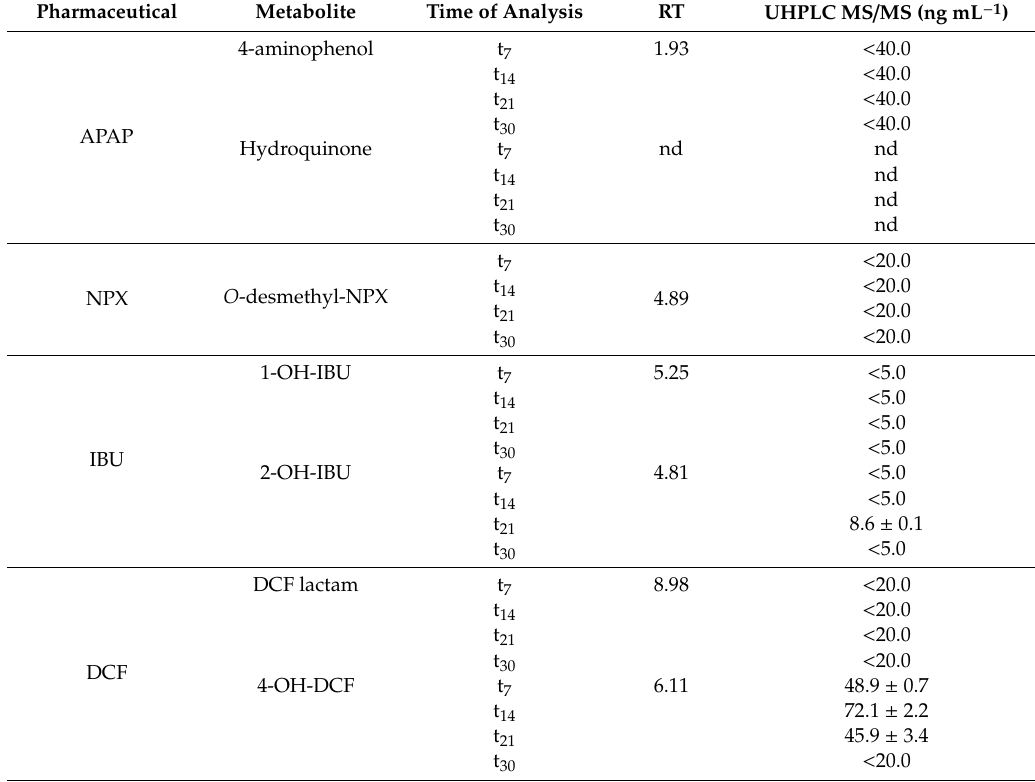
Table 6. Secondary metabolites identified in the AS1 assay during 30 days of